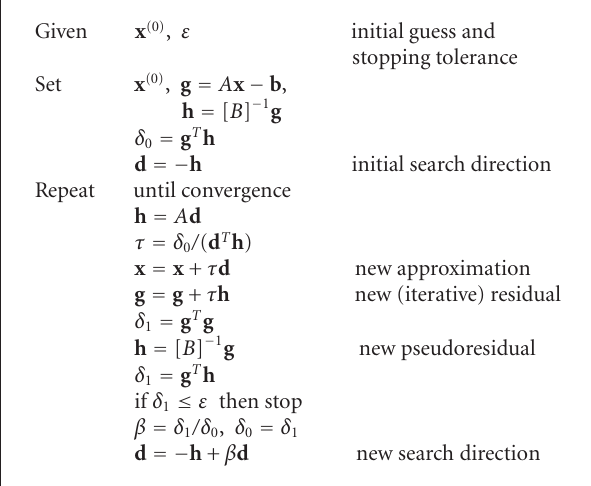
Algorithm 2: Preconditioned conjugate gradient